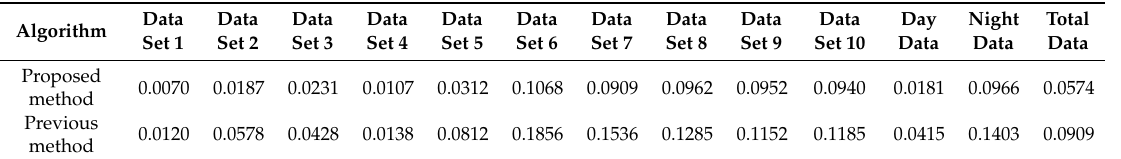
Table 1. Average error rates of the tested algorithms.